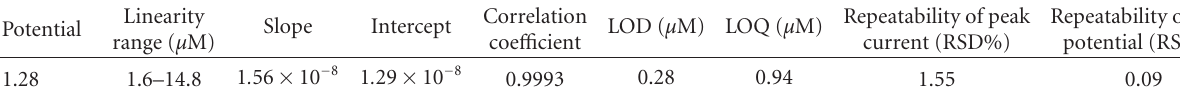
Table 2: Regression and validation data of calibration line of fludarabine.